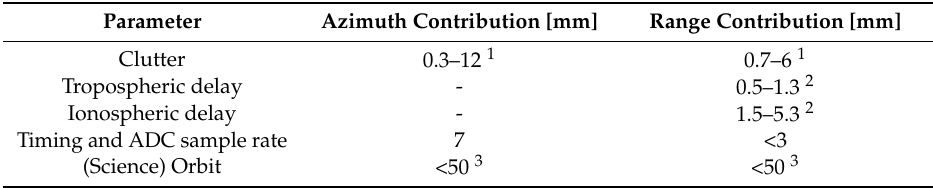
Table 8. Estimations for the major error contributions in the geolocation result.